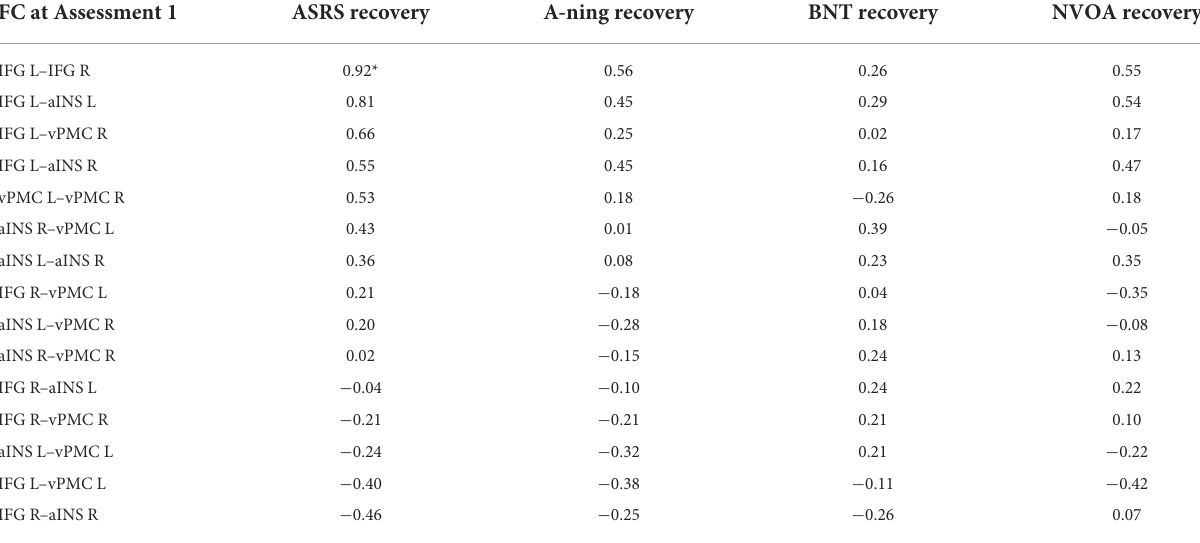
TABLE 10 Correlation between recovery in behavioral measurements and functional connectivity between ROIs, results presented in descending order (based on the ASRS